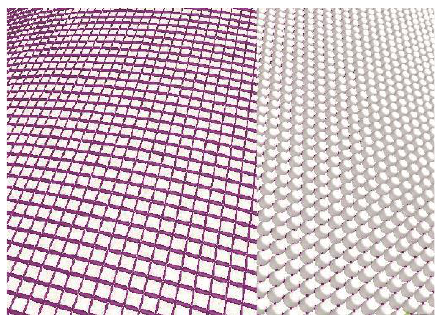
Figure 1. Virtual film structure based on particle cluster method.